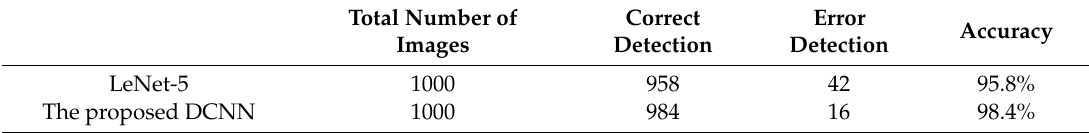
Table 2. Recognition rate of different categories of samples in the test set.